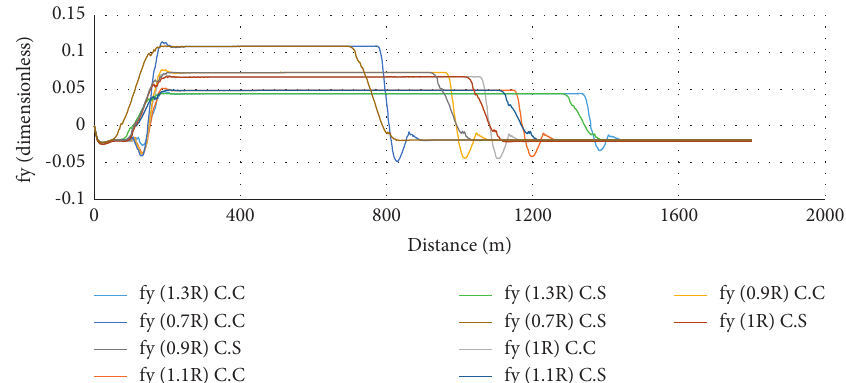
Figure 4: Side friction coefficient versus path length for various radii of simple and spiral horizontal curves for trucks; C.C is the simple horizontal curve, and S.C is the spiral horizontal curve.